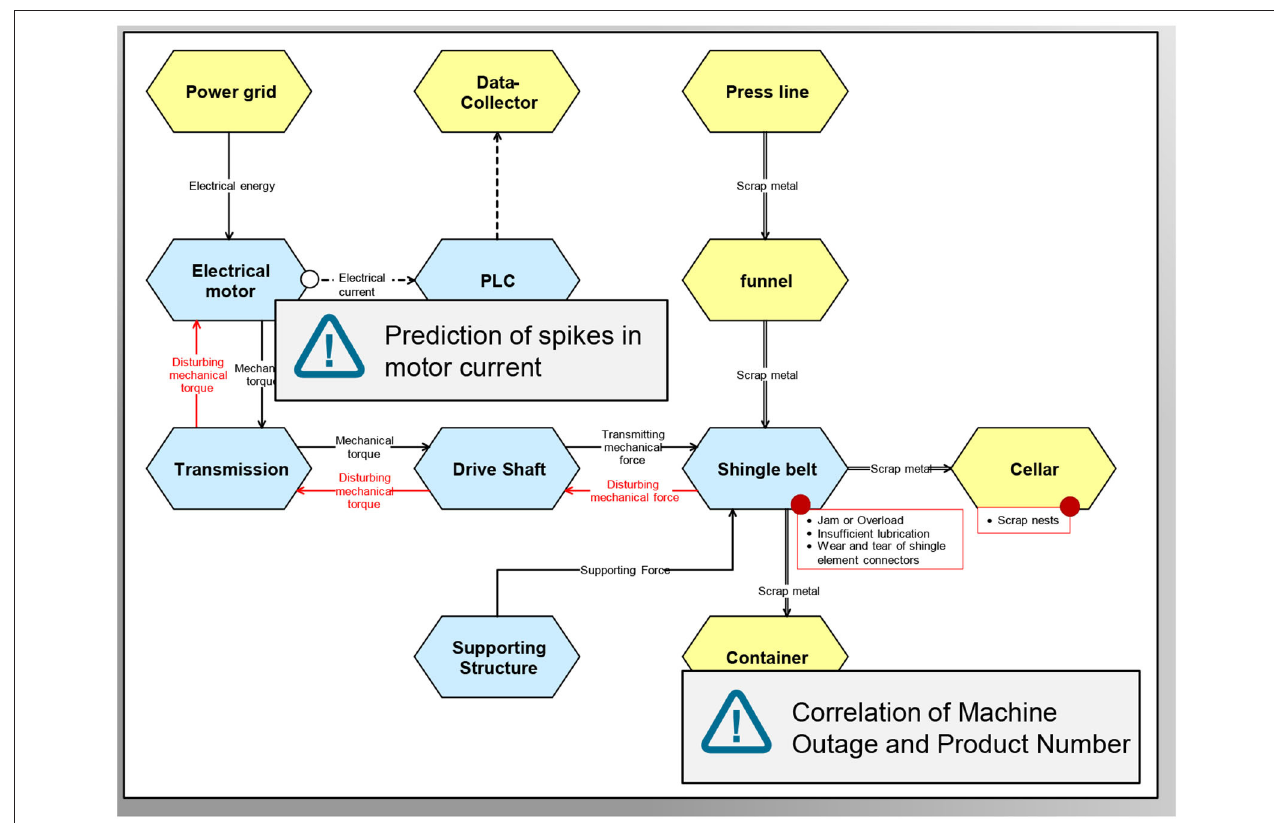
FIGURE 4 | Identification of Use Cases along the machine structure.